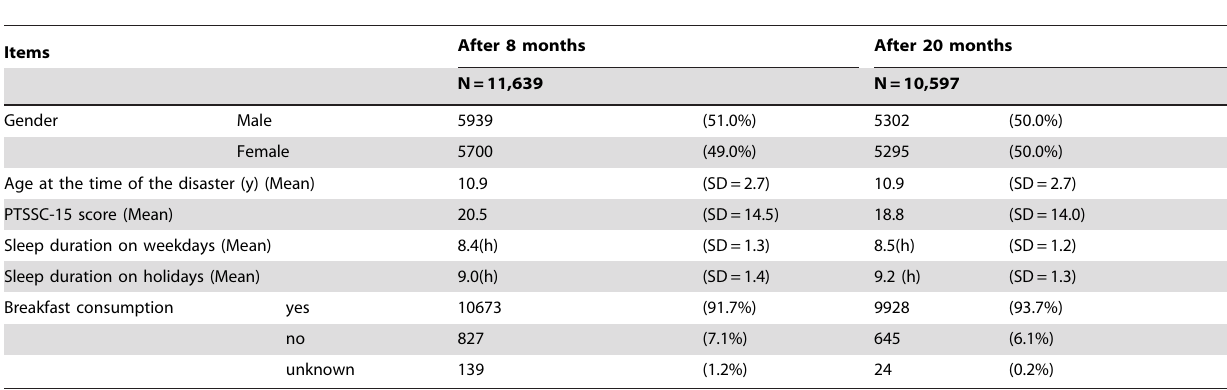
Table 2. Characteristics of children affected by the 2011 Japan Earthquake and Tsunami.